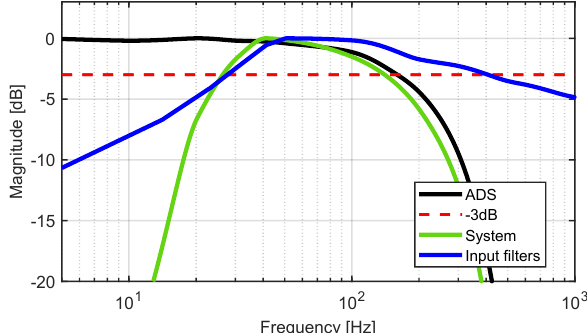
Figure 13. Frequency response of EMG module with filter.